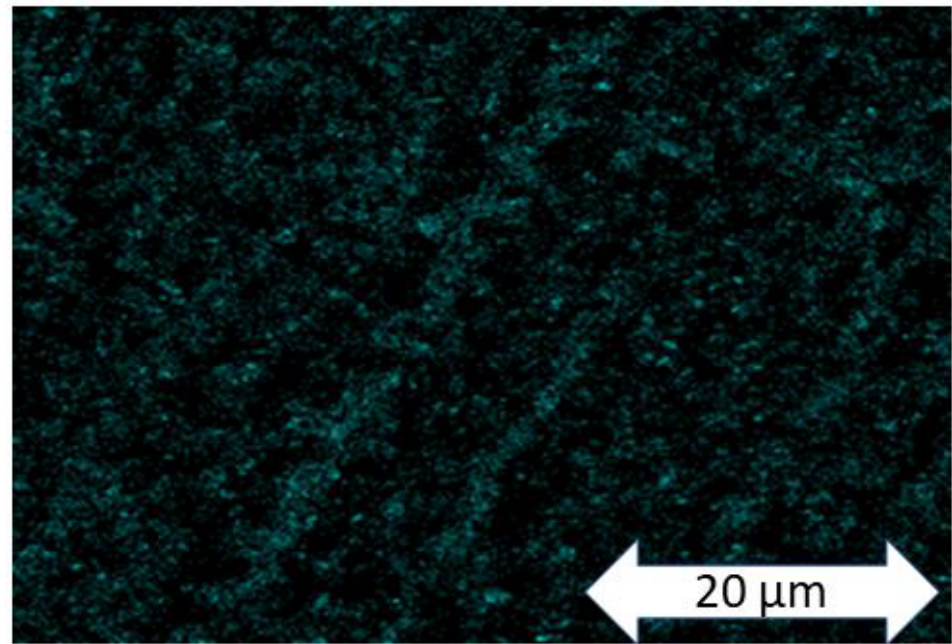
Figure 15. SEM mapping of the titanium element in the ORMOSIL coating on Mg ZK10-containing TiO 2 nanocontainers loaded with a 5-amino-1,3,4-thiadyazole-2-thiol (5-ATDT), indicating the homogeneous distribution of nanocontainers in the coating.